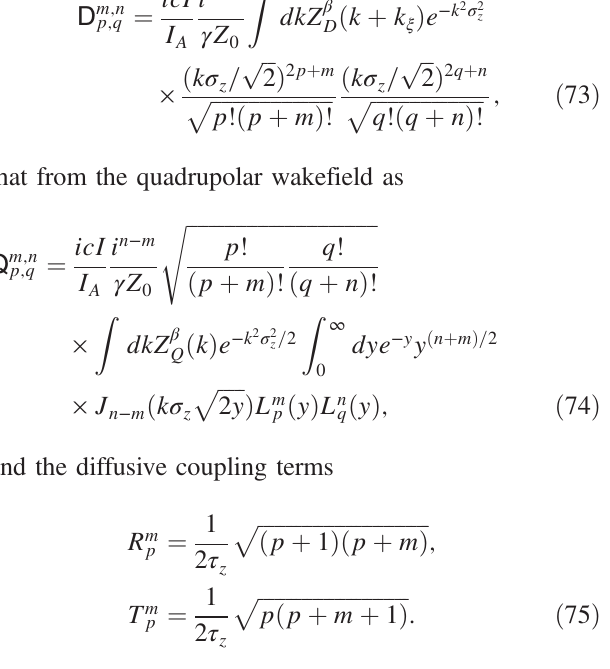
ffiffiffi p 2 Þ 2 q þ n ffiffiffiffiffiffiffiffiffiffiffiffiffiffiffiffiffiffiffiffiffi